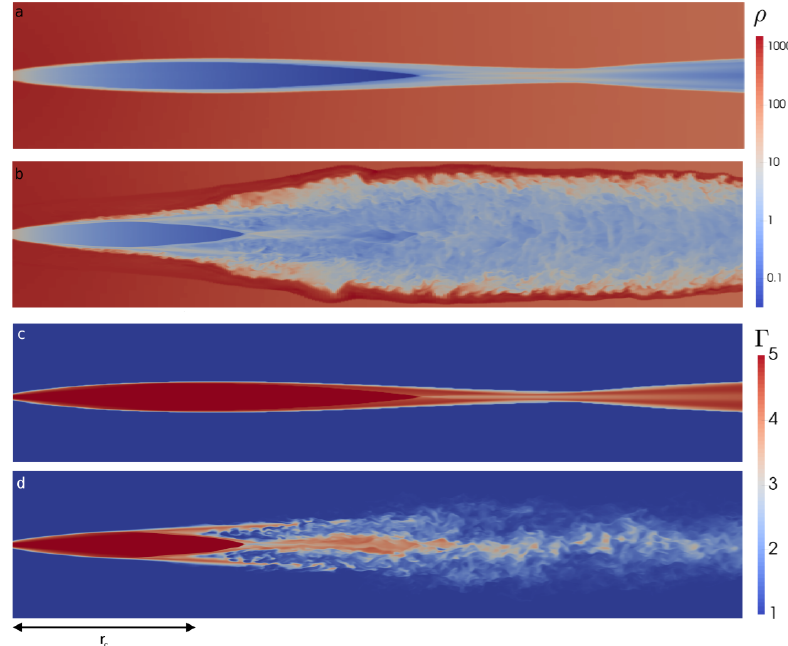
Figure 5. ( a , b ) Jet density ( ρ ) in arbitrary units; and ( c,d ) Lorentz factor ( Γ ) for a model corresponding to a CI-driven FR I jet making its way through a galactic corona. A section of the jet, containing the jet axis is shown for ρ ( a ) and Γ ( c ) in the steady state solution and ρ ( b ) and Γ ( d ) in the final 3D solution. The results correspond to simulation C1 in [162]. The jet to ambient density ratio is 1.6 × 10 − 2 and the initial jet Lorentz factor is 5. The jet kinetic power is 2 × 10 44 ergs/s. (Figure adapted from [162] kindly provided by the